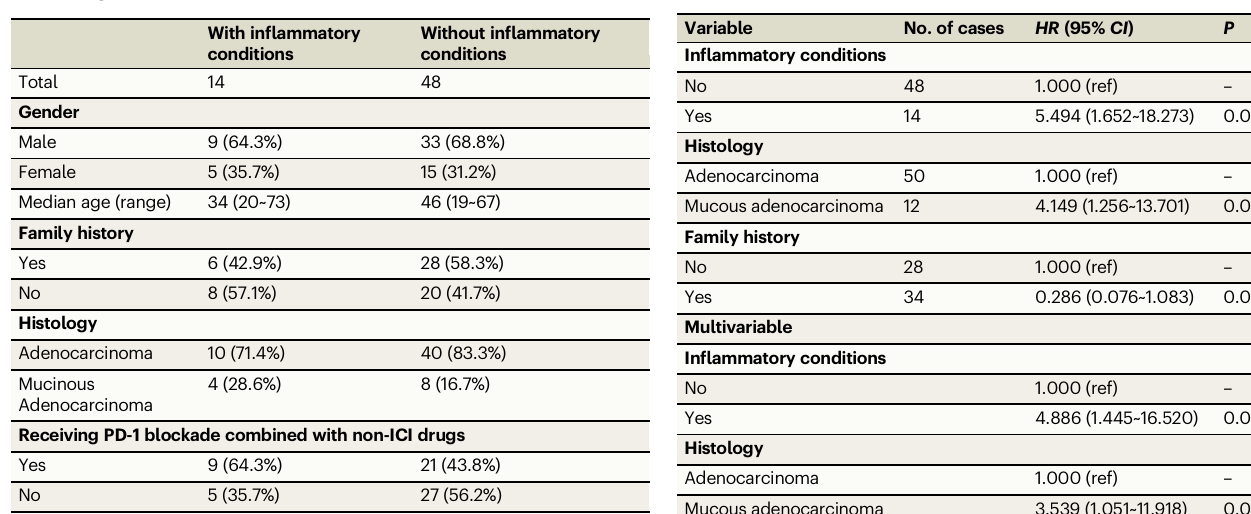
Table2 | Univariate and multivariateCox proportional hazards regression for PFS